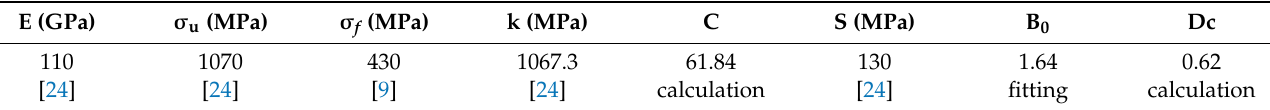
Table 1. VHCF damage parameters of TC21 titanium alloy.